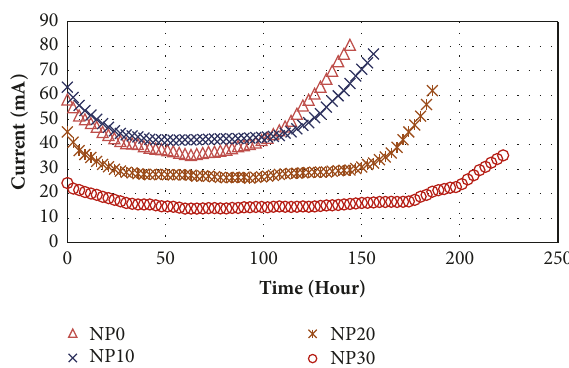
Figure 9: Typical curves of corrosion current versus time of concrete specimens tested after 28 days of